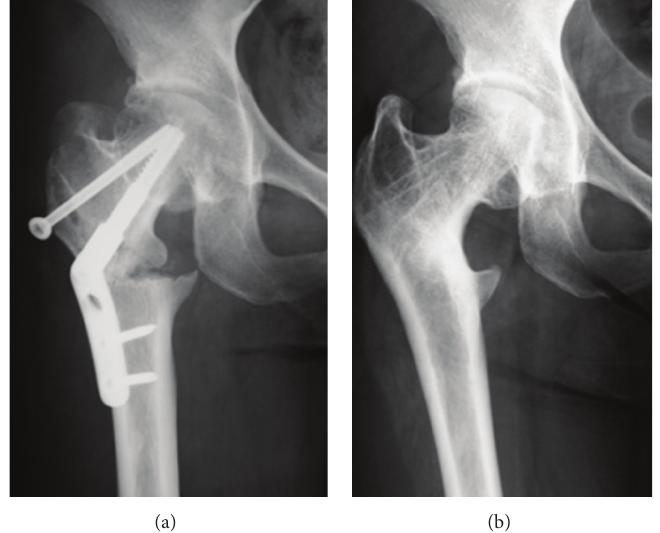
Figure 7: Case 2. (a) Anteroposterior X-ray image of the right hip after femoral curved varus osteotomy, (b) 9 years after osteotomy, X-ray image showing a spherical femoral head with joint space and remodeling of the femoral